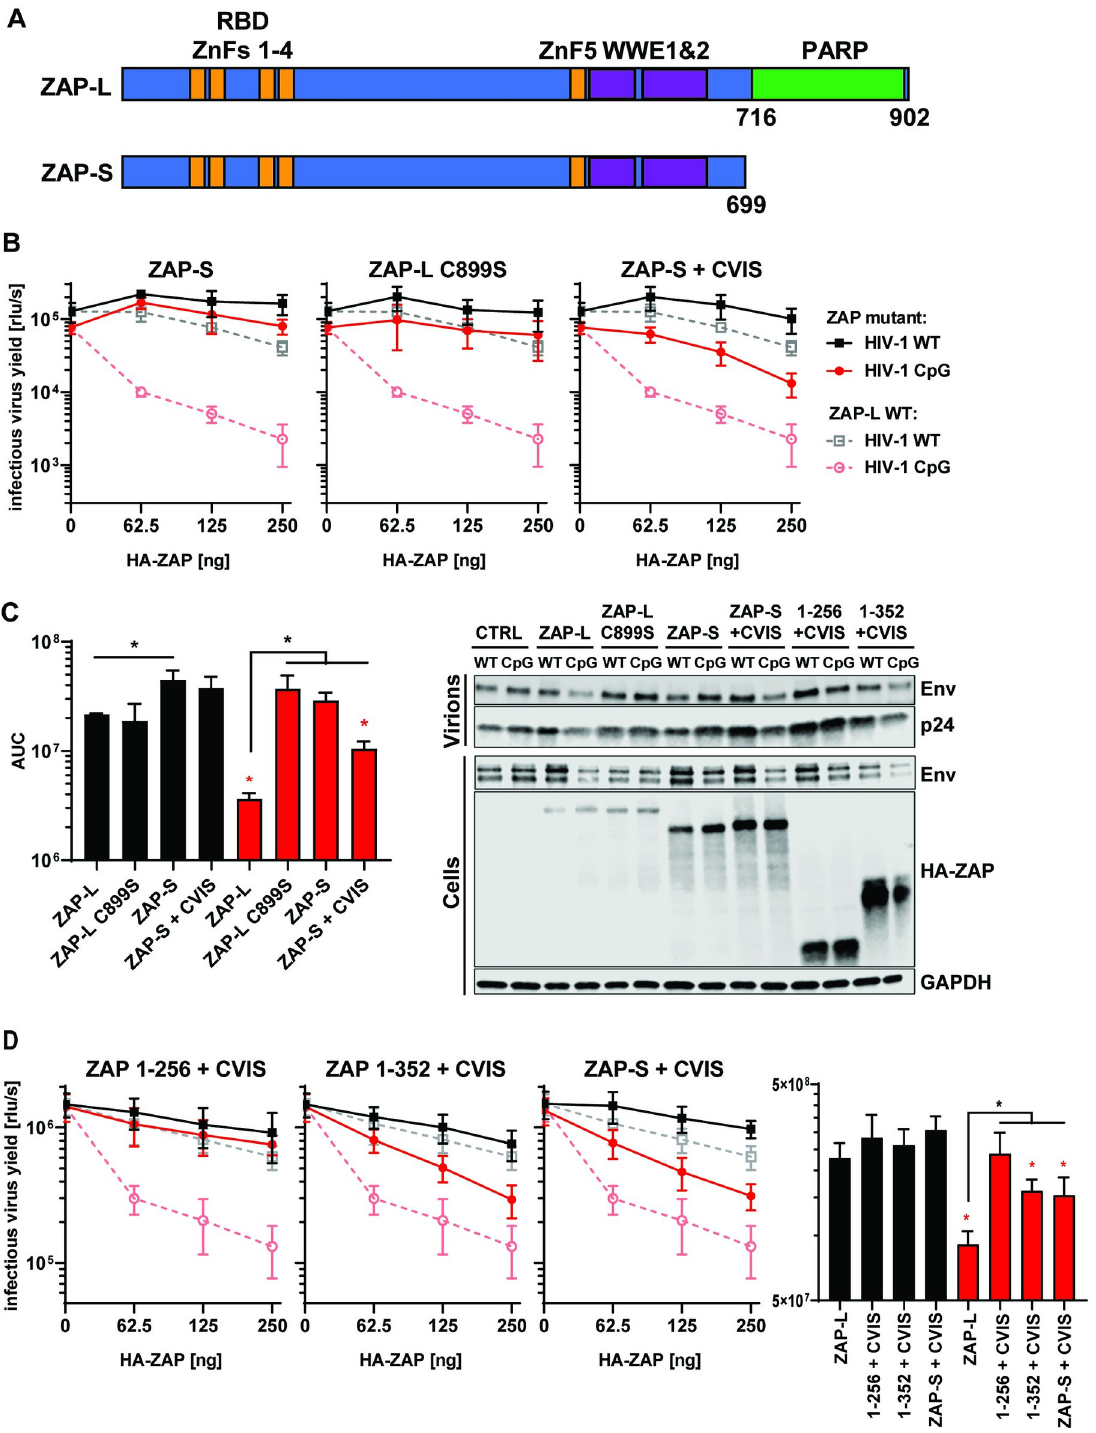
Fig 3. Contribution of CaaX motif to ZAP’s antiviral activity. (A) Schematic showing ZAP-L, which contains PARP domain and CaaX motif (amino acids “CVIS”) and short isoform of ZAP (ZAP-S). (B) Infectious virus yield from HEK293T ZAP KO co-transfected with WT (black) and mutant (red) virus and increasing concentration of ZAP-L (dashed line), ZAP-S, ZAP-L with mutated crucial cysteine (C899S) in CaaX or ZAP-S with added CVIS motif (solid lines). (C) Corresponding AUC values and representative western blot (250ng). (D) Infectious virus yield from HEK293T ZAP KO co-transfected with both viruses and pcDNA encoding truncated ZAP (1–256 or 1–352) with added CVIS motif and corresponding AUC values. Mean of n = 3–5 +/- SD. � p < 0.05 for HIV-1 CpG compared to HIV-1 WT for the same ZAP construct. � p < 0.05 for the comparisons demarked by the lines. https://doi.org/10.1371/journal.ppat.1009726.g003 PLOS Pathogens| https://doi.org/10.1371/journal.ppat.1009726 October 25,